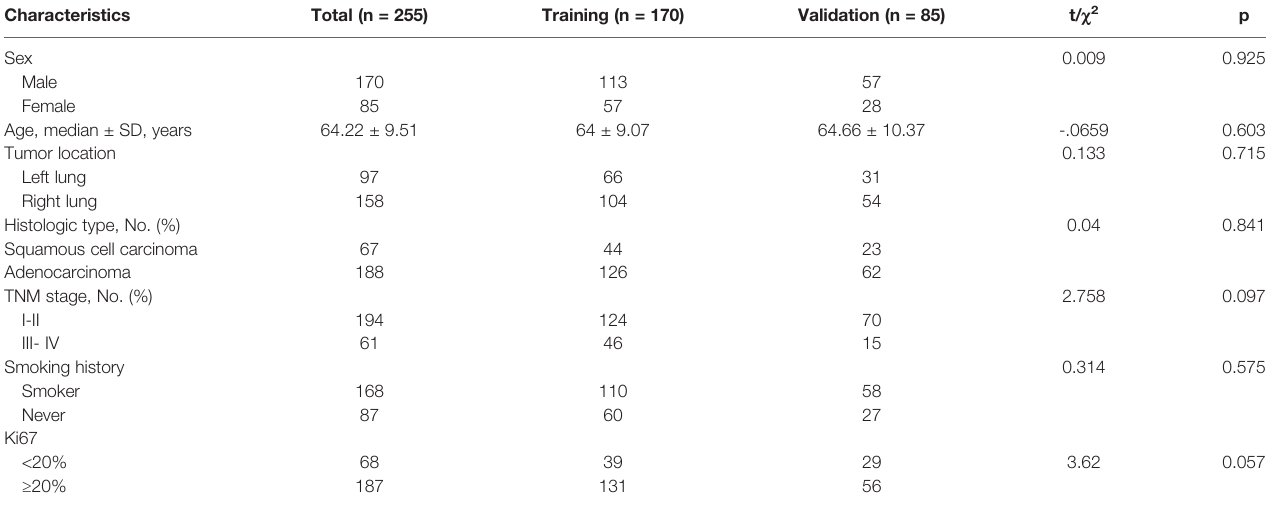
TABLE 1 | Characteristics of the training and validation